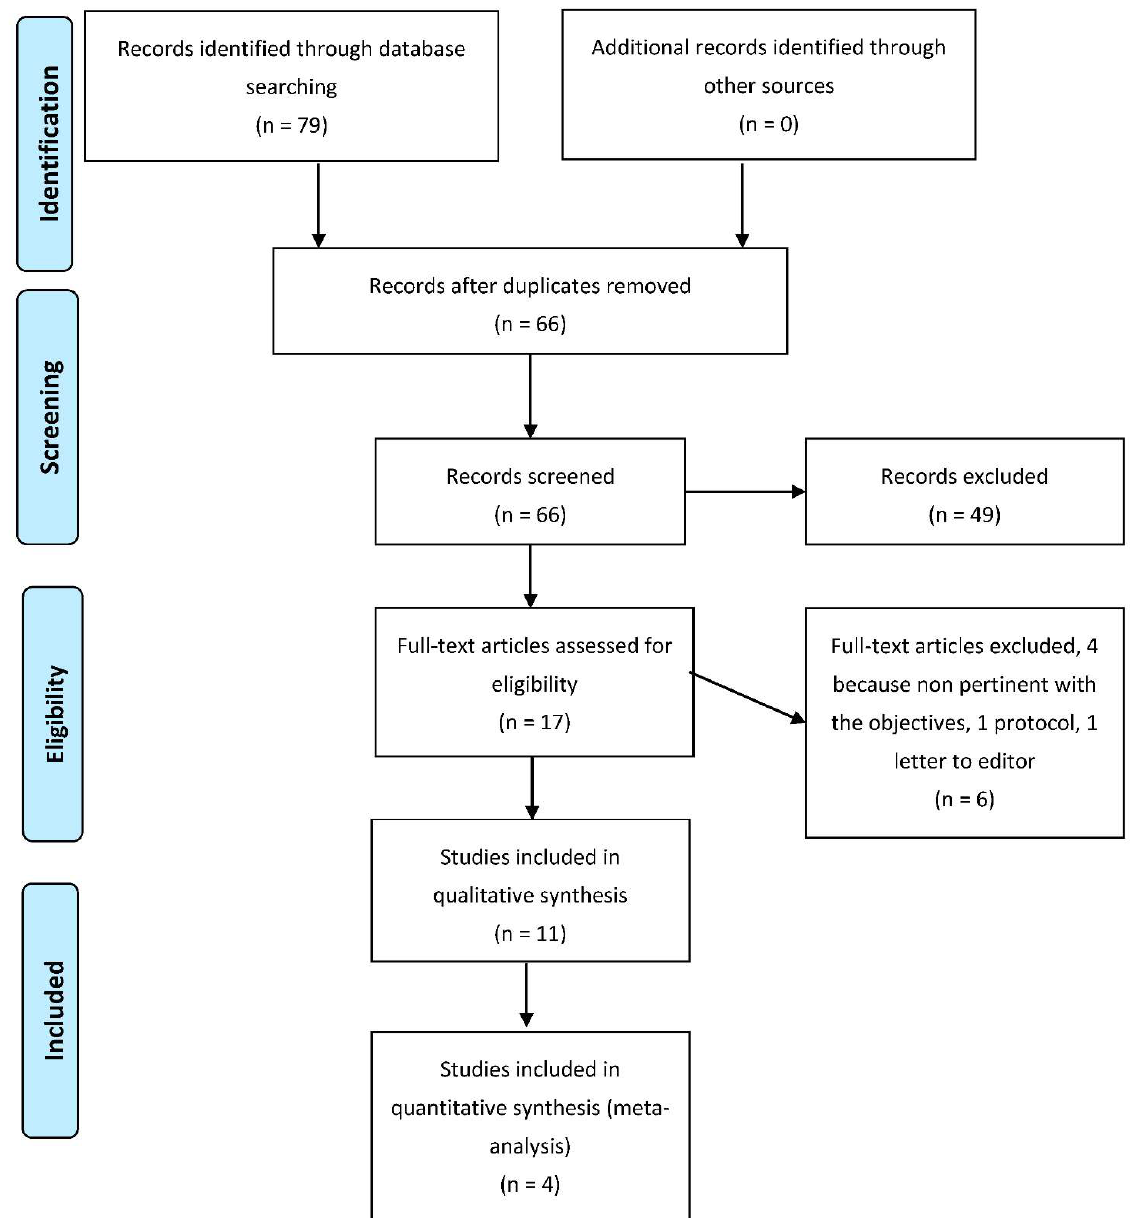
Figure 1. Flow-chart of search and screening process